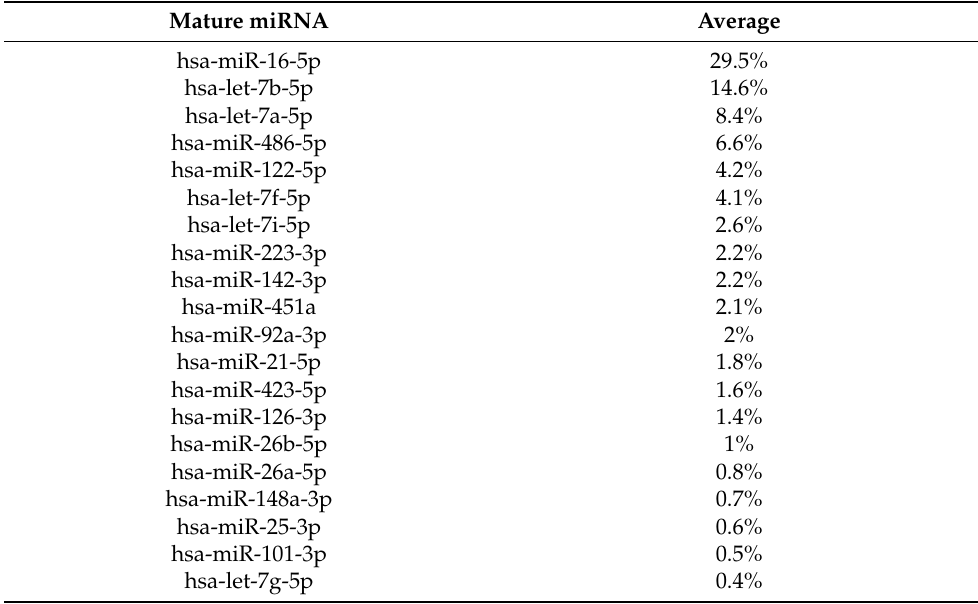
Table 3. Average of the most expressed 20 miRNAs found in the samples. Mature